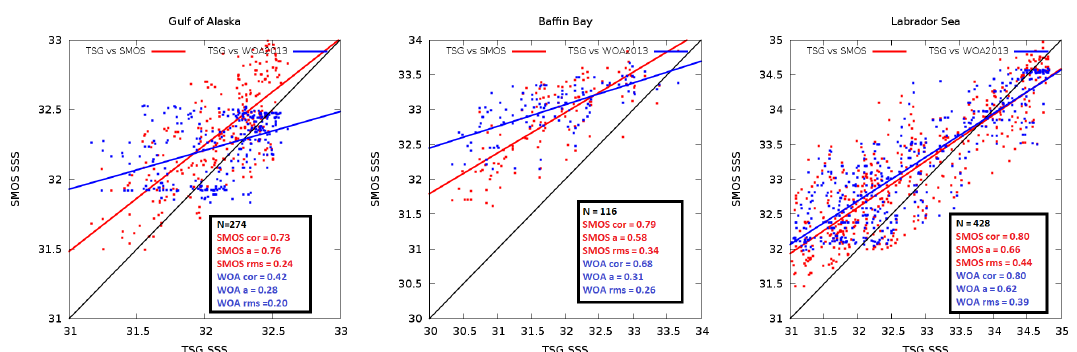
Figure 10. Correlation between SMOS SSS and TSG SSS in the three transects presented in Figure 9: Gulf of Alaska ( left ); Baffin Bay (in the middle ); and Labrador Sea ( right ). Red line is the linear regression between SMOS SSS and TSG SSS (red points) and blue line is the linear regression between WOA SSS and TSG SSS (blue points). The number of measurements (N), the correlation coefficient (cor), the coefficient of linear regression (a) and the RMS of the residuals are shown in the legend for SMOS SSS (red) and WOA SSS